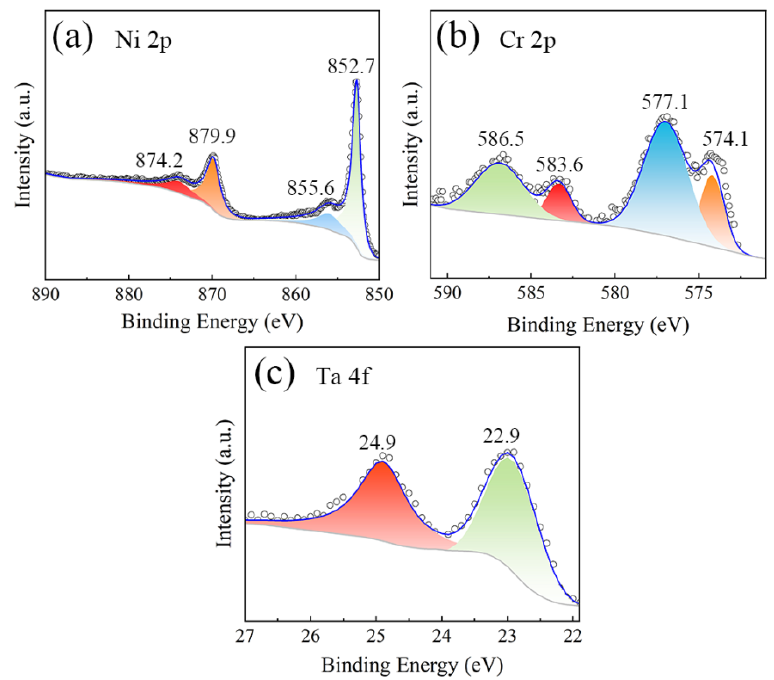
Figure 8. XPS pattern of TLP-diffusion-bonded joint using low-B interlayer. ( a ) Ni 2p; ( b ) Cr 2p; ( c ) Ta 4f.